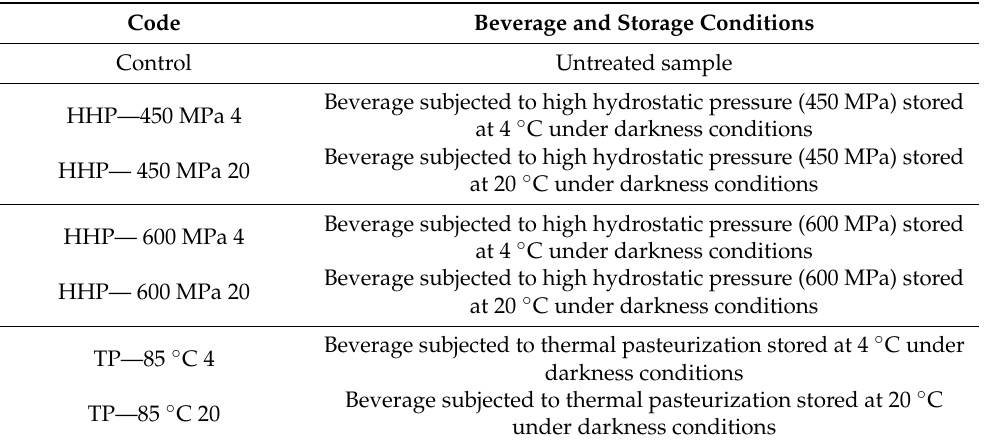
Table 1. Codification of samples included in the experimental